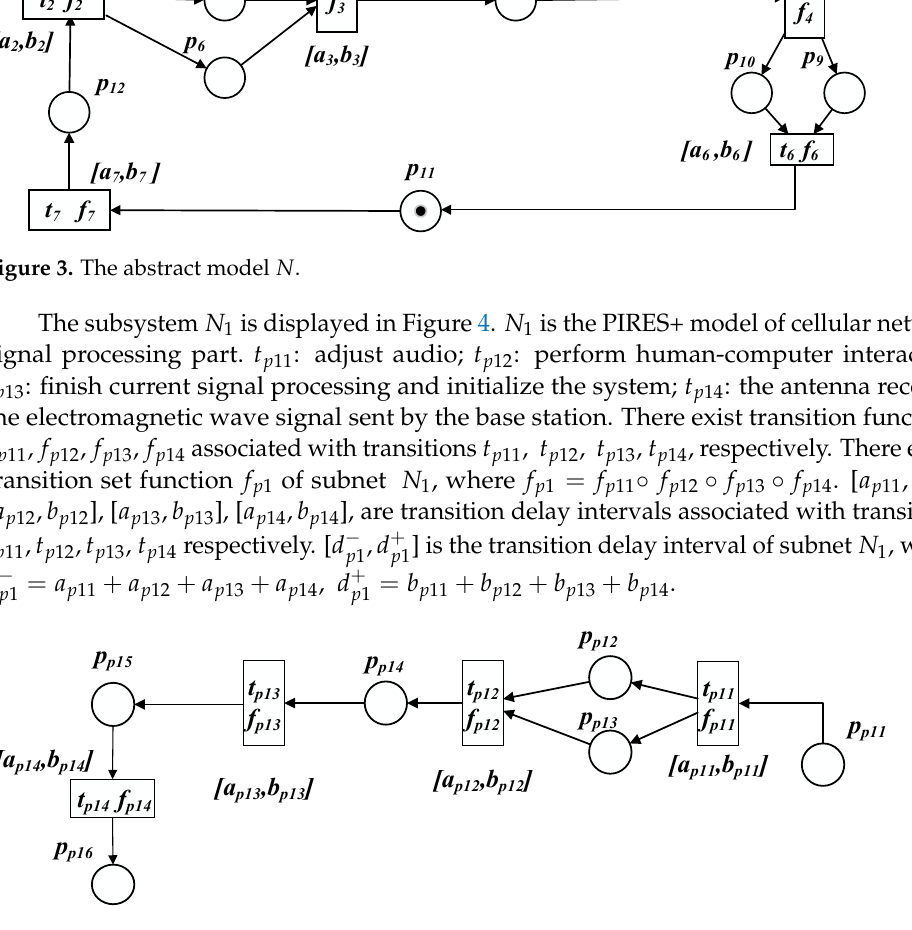
Figure 5. The subnet model 𝑁 (cid:2870) . The subsystem 𝑁 (cid:2871) is displayed in Figure 6. 𝑁 (cid:2871) is the PIRES+ model of the WLAN signal processing part, where 𝑡 (cid:3043)(cid:2871)(cid:2869) : human-computer interaction part; 𝑡 (cid:3043)(cid:2871)(cid:2870) : finish the cur- rent signal processing and initialize the system; 𝑡 (cid:3043)(cid:2871)(cid:2871) : the terminal receives WLAN sig- nals from different sources. There exist transition functions 𝑓 (cid:3043)(cid:2871)(cid:2869) , 𝑓 (cid:3043)(cid:2871)(cid:2870) , 𝑓 (cid:3043)(cid:2871)(cid:2871) , associated with transitions 𝑡 (cid:3043)(cid:2871)(cid:2869) , 𝑡 (cid:3043)(cid:2871)(cid:2870) , 𝑡 (cid:3043)(cid:2871)(cid:2871) , respectively. There exists transition set function 𝑓 (cid:3043)(cid:2871) of subnet 𝑁 (cid:2871) , where 𝑓 (cid:3043)(cid:2871) = 𝑓 (cid:3043)(cid:2871)(cid:2869) ∘ 𝑓 (cid:3043)(cid:2871)(cid:2870) ∘ 𝑓 (cid:3043)(cid:2871)(cid:2871) . There exist transition delay intervals [ 𝑎 (cid:3043)(cid:2871)(cid:2869) , 𝑏 (cid:3043)(cid:2871)(cid:2869) ], [ 𝑎 (cid:3043)(cid:2871)(cid:2870) , 𝑏 (cid:3043)(cid:2871)(cid:2870) ], [ 𝑎 (cid:3043)(cid:2871)(cid:2871) , 𝑏 (cid:3043)(cid:2871)(cid:2871) ] associated with transitions 𝑡 (cid:3043)(cid:2871)(cid:2869) , 𝑡 (cid:3043)(cid:2871)(cid:2870) , 𝑡 (cid:3043)(cid:2871)(cid:2871) , respectively. [ 𝑑 (cid:3043)(cid:2871)(cid:2879) , 𝑑 (cid:3043)(cid:2871)(cid:2878) ] is the transition delay interval of subnet 𝑁 (cid:2871) , where 𝑑 (cid:3043)(cid:2871)(cid:2879) = 𝑎 (cid:3043)(cid:2871)(cid:2869) + 𝑎 (cid:3043)(cid:2871)(cid:2870) + 𝑎 (cid:3043)(cid:2871)(cid:2871) , 𝑑 (cid:3043)(cid:2871)(cid:2878) = 𝑏 (cid:3043)(cid:2871)(cid:2869) + 𝑏 (cid:3043)(cid:2871)(cid:2870) + 𝑏 (cid:3043)(cid:2871)(cid:2871) . p p35 t p33 f p33